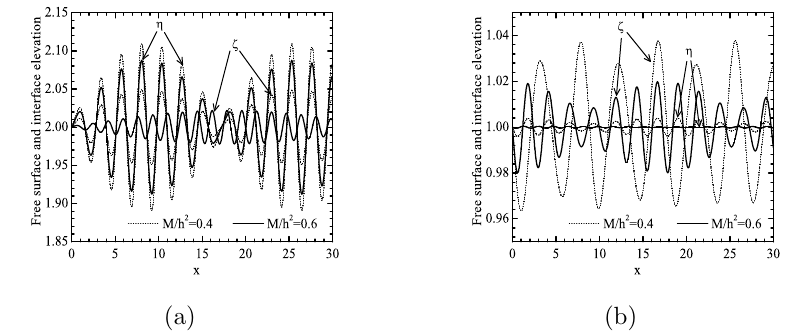
Figure 11. Variation of free surface elevation η and interface elevation ζ for various values of surface tension effect parameter M/h 2 : (a) waves with surface mode and (b) waves with interface